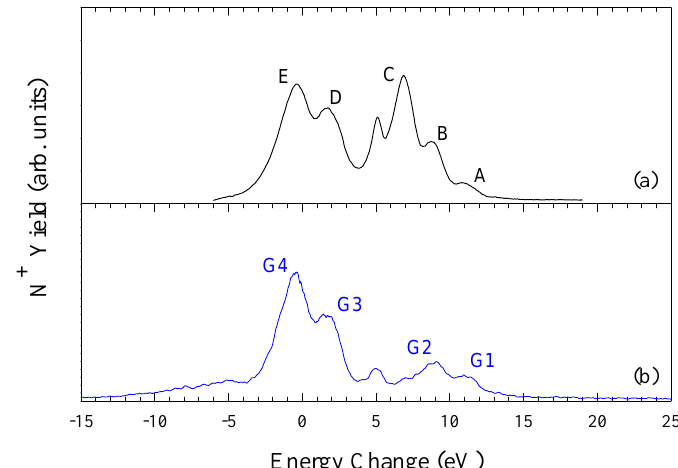
Figure 4: Energy change spectra for electron capture by (a) a mixed beam of ground state and metast- able N 2+ ions and (b) a pure ground state beam of N 2+ ions in H